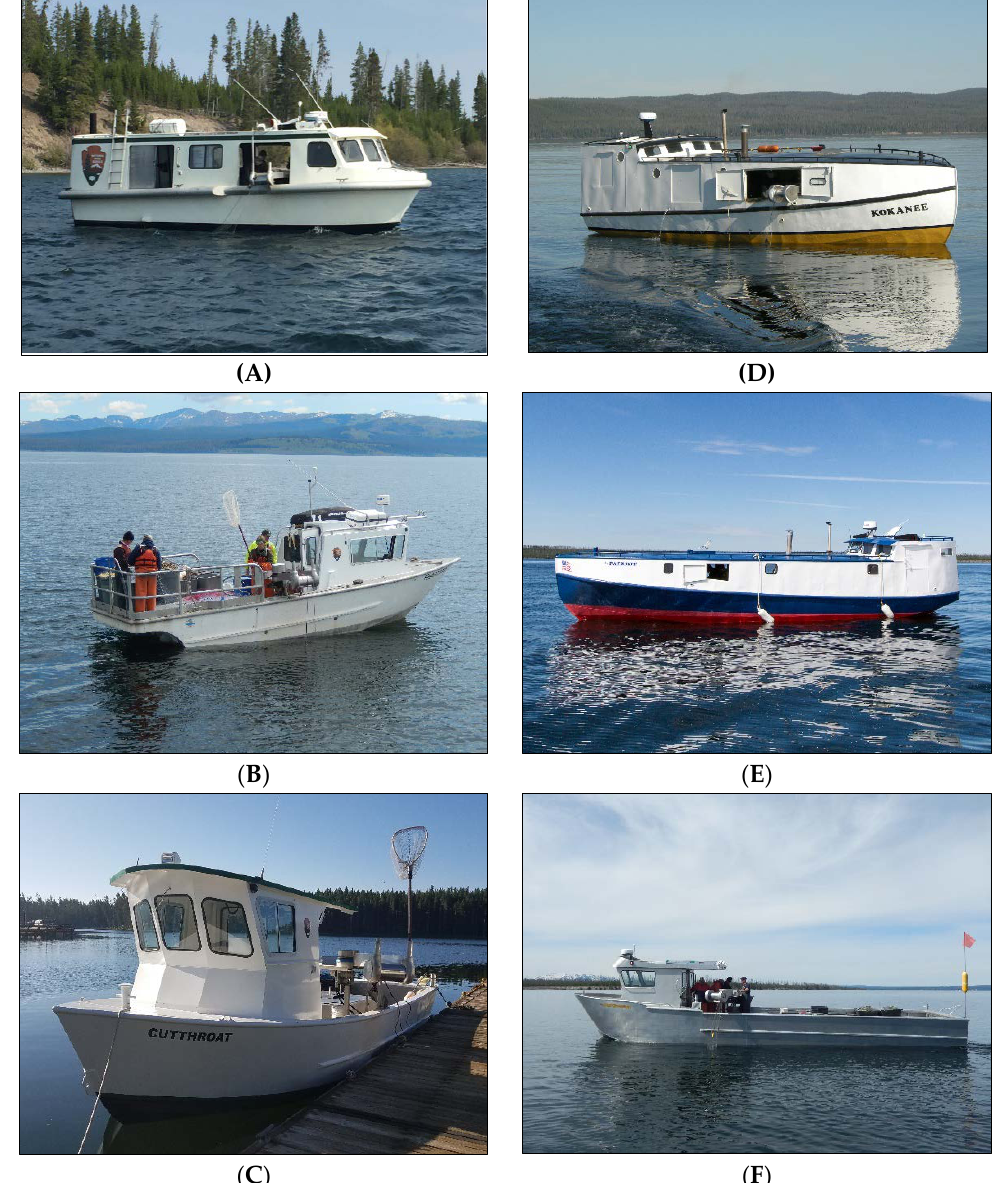
Figure A4. Lake trout gillnetting boats on Yellowstone Lake included ( A – C ) National Park Service Freedom, Hammerhead, and Cutthroat, and ( D – F ) Hickey Brothers Research, LLC. Kokanee, Patriot, and Northwester